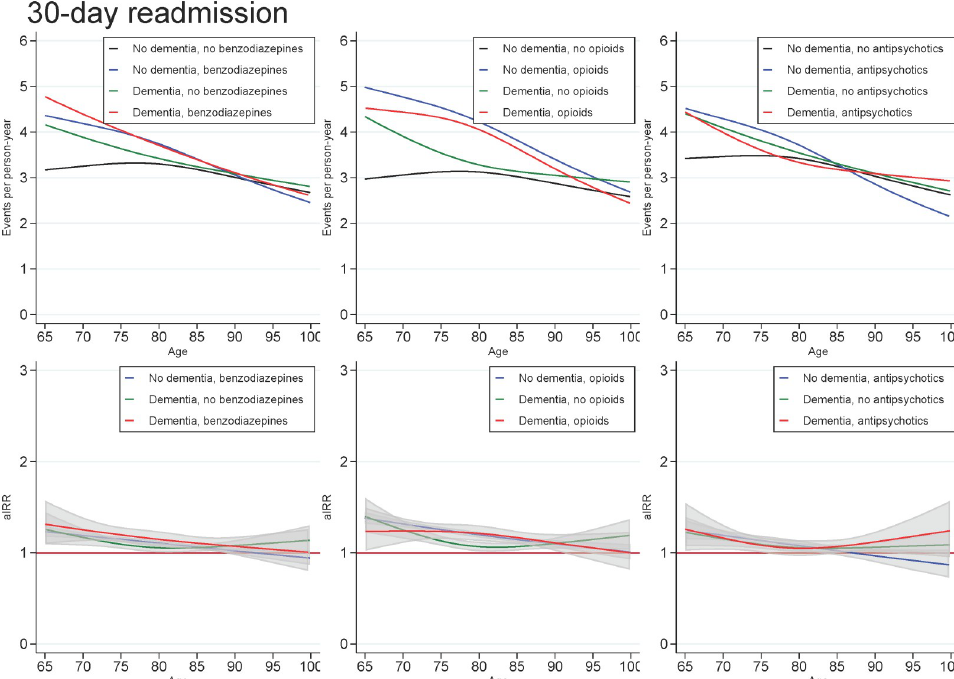
Fig 3. Unadjusted readmission rates and adjusted incidence (readmission) rate ratios for patients with dementia (without medication use), patients with use of benzodiazepines, opioids or antipsychotics (without dementia), and patients with both or neither exposures, plotted as a function of age. Abbreviations: aIRR: adjusted incidence (readmission) rate ratios. IRRs adjusted for sex, age, calendar period, cohabitation status, length of stay, type of pneumonia diagnosis, time since discharge, somatic comorbidities, psychiatric comorbidities, and alcohol/substance abuse.